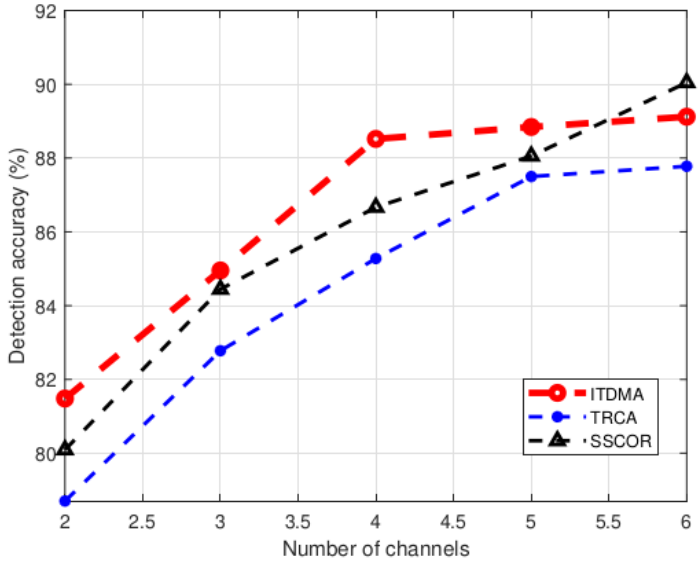
Figure 7. Detection accuracy comparison versus the number of